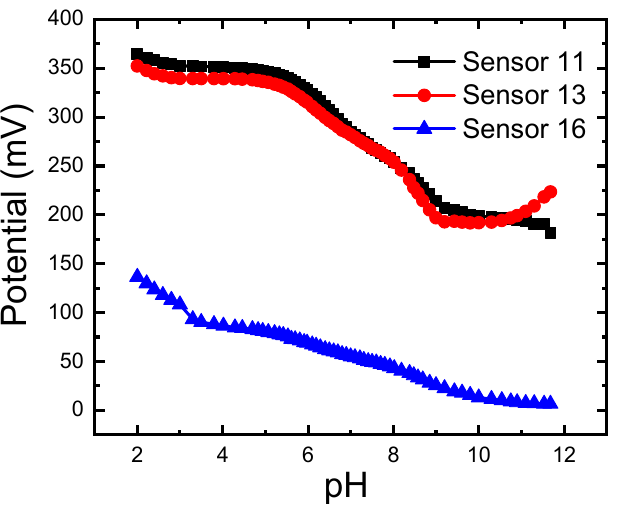
Figure 8. Effect of pH on the response of carbon paste electrode (CPE, sensor 11); PVC membrane coated on carbon paste electrode (C-CPE, sensor 13); PVC/CD plasticized carbon paste electrode (P-CPE, sensor 16) immersed in 10 − 3 M LF. The electrode compositions (%, wt / wt ) are given in (Table 1). All measurements were performed at room te mperature of 22 ± 2 °C . Table 2. Effect of the pH on the response characteristics of the optimized sensors .